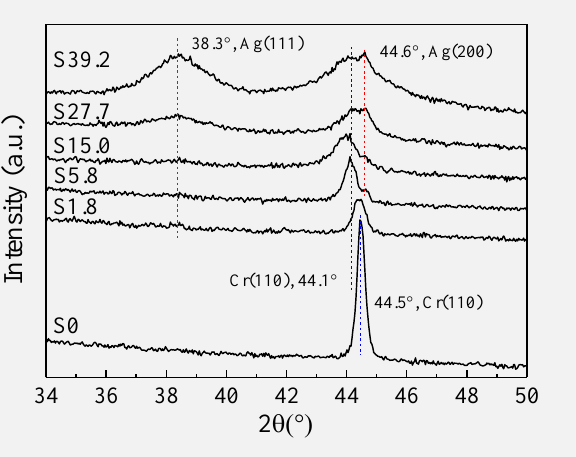
Figure 1. XRD patterns of the Cr – Ag film samples with glass substrate. SEM surface images of the samples with glass substrate are shown in Figure 2. Nano- grains with facets are observed for sample S0–S15.0, and the surface becomes blurred and mound-like for samples S27.7 and S39.2. The surface change is related to film structural